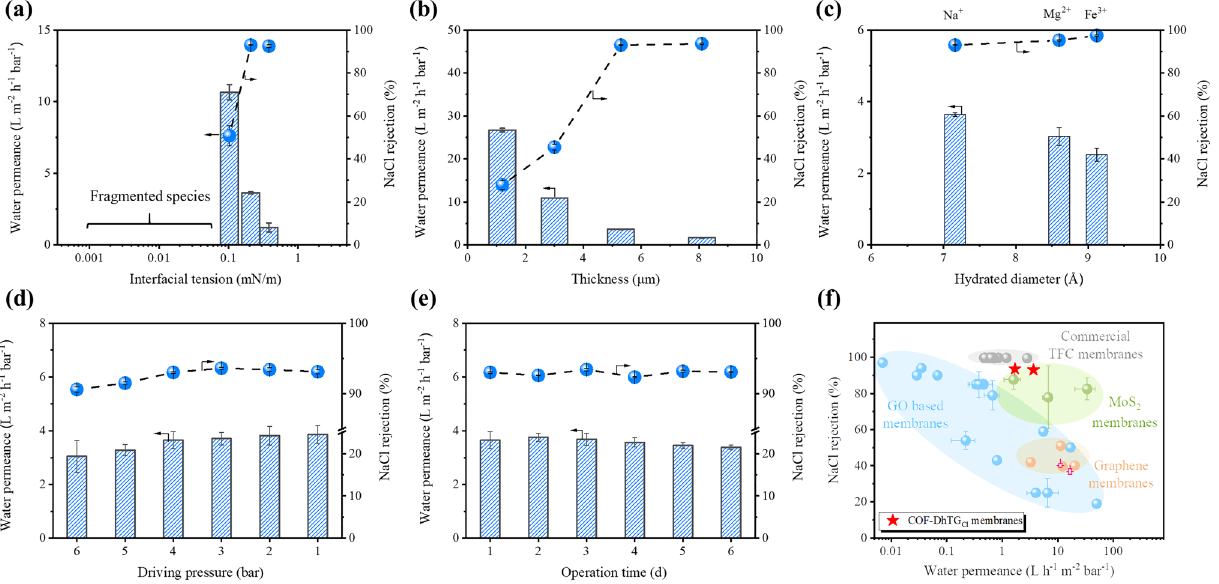
Fig. 5 Desalination performances of COF-DhTG Cl membranes. a Membranes prepared by different interfacial tension, b membranes with dif- ferent thickness, c membranes undergone different salt solution, d varied driving pressure test, e long-term operation test and f comparison of desalination performances with those reported in the